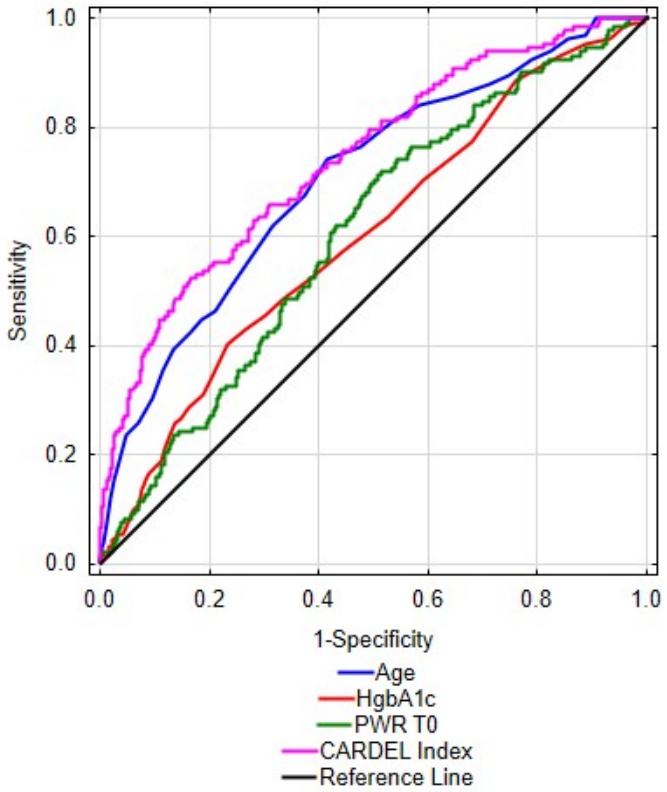
Figure 6. Receiver operating characteristic (ROC) analysis for the CARDEL index as a determinant of postoperative delirium after CABG compared to the separate components of the index itself. Legend: AUC—area under the curve, HbA1c—glycated hemoglobin, PWR—P Platelet-to-WBC